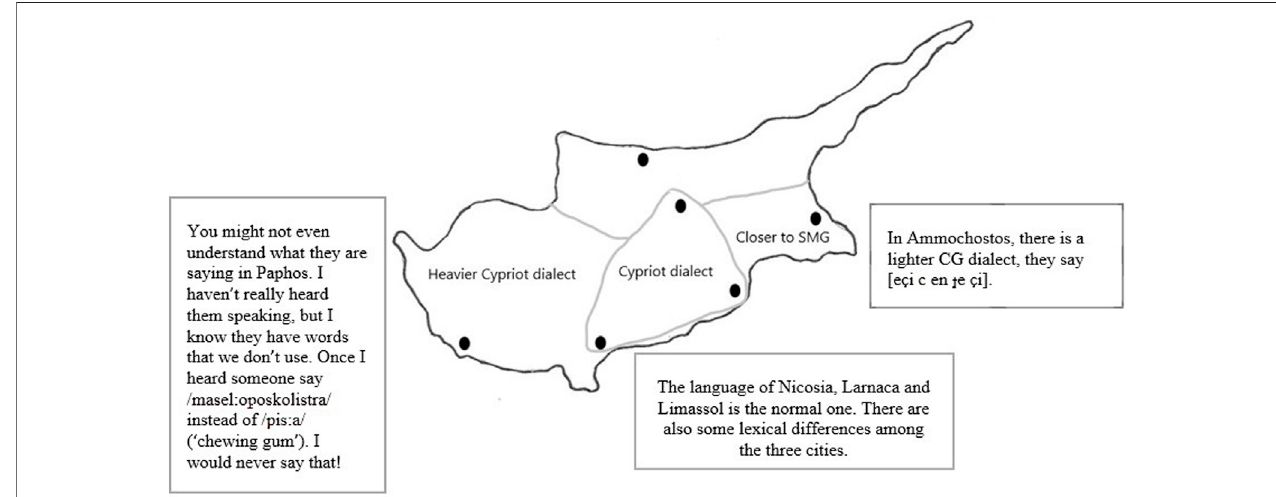
FIGURE 8 | Map drawn by participant 6.